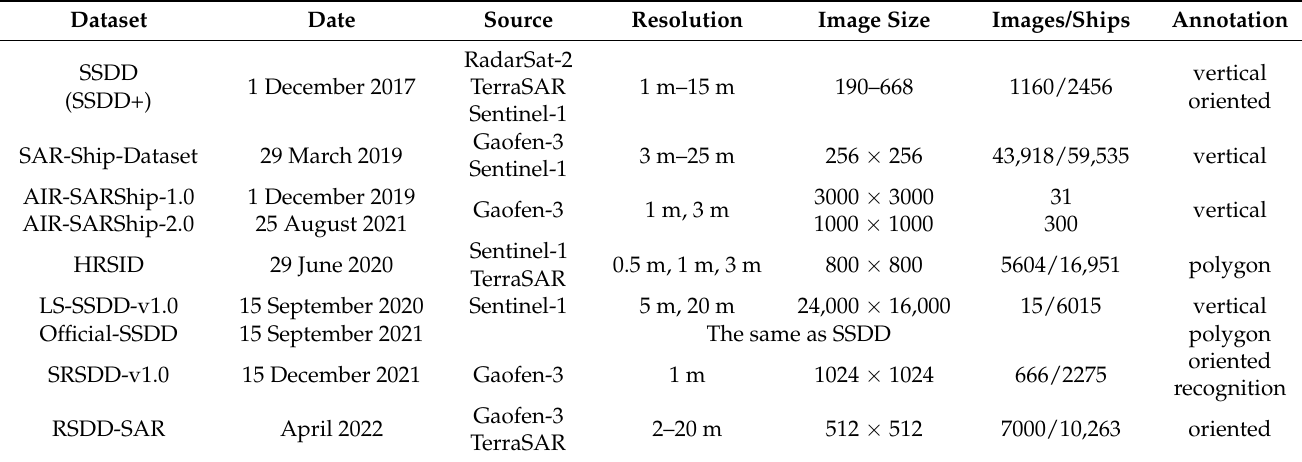
Table 13. Detail information of existing public